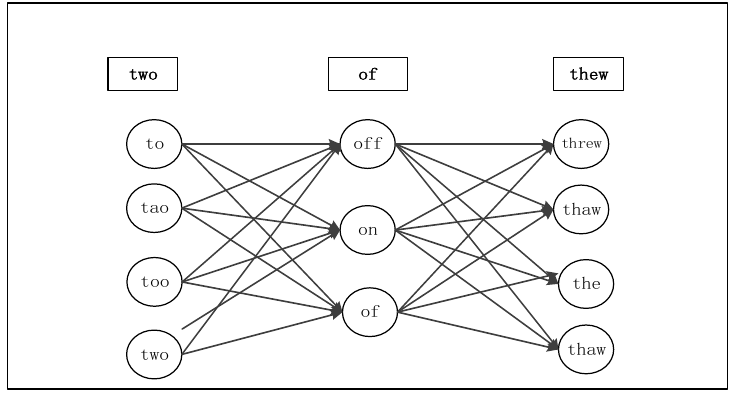
Figure 5. Noisy channel model.